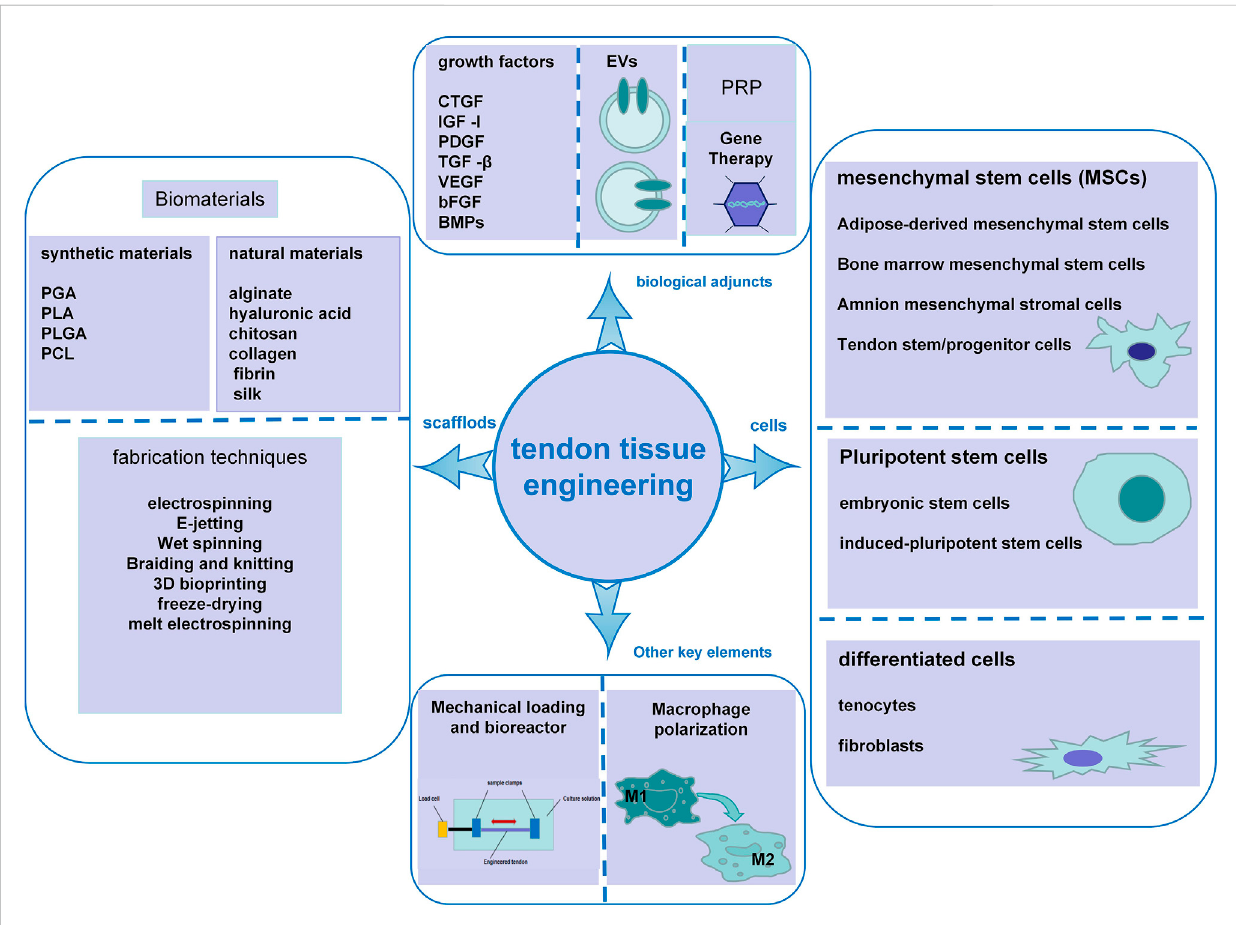
FIGURE 1 Schematic illustration of the key elements in tendon tissue engineering, including scaffold biomaterials and fabrication techniques, cells, biological adjuncts, mechanical loading and bioreactors, and macrophage polarization.